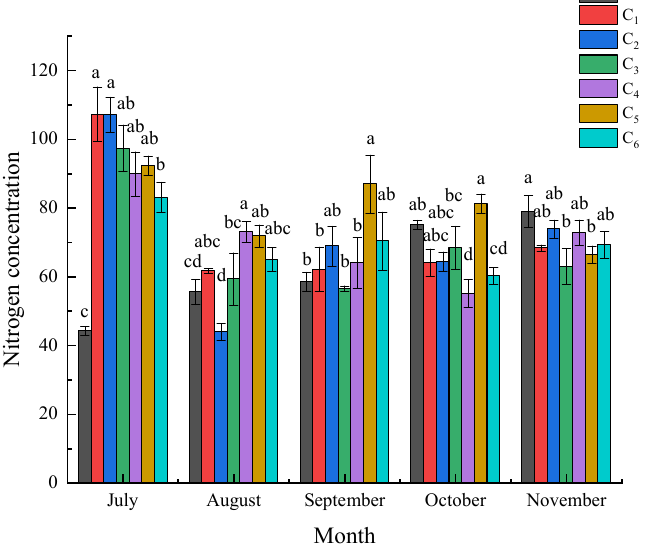
Figure 1. The nitrogen concentration in the roots of S. sebiferum container seedlings with different biochar treatments. Lowercase letters represent significance at 0.05 level and the same letter indicates no significant difference in full text.